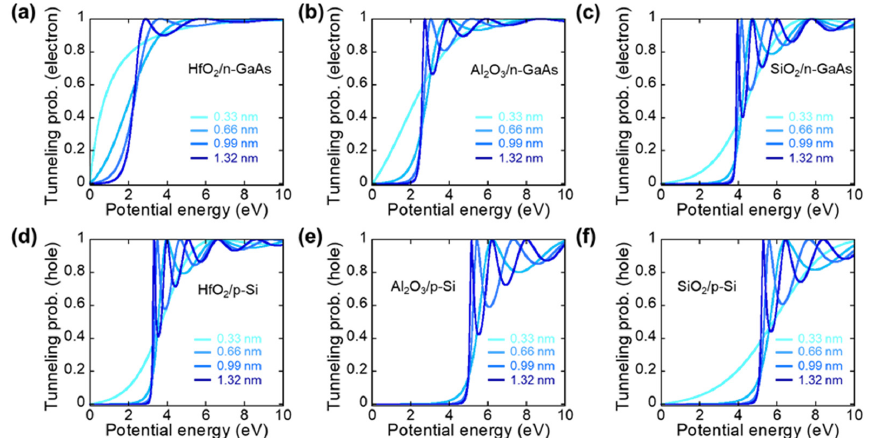
Figure 2. Tunneling probability of an electron across the UT interfacial layer with different thicknesses: ( a ) HfO 2 /n-GaAs, ( b ) Al 2 O 3 /n-GaAs, and ( c ) SiO 2 /n-GaAs; ( d – f ) tunneling probability of holes across these UT interfacial layers with p-Si with different thicknesses.